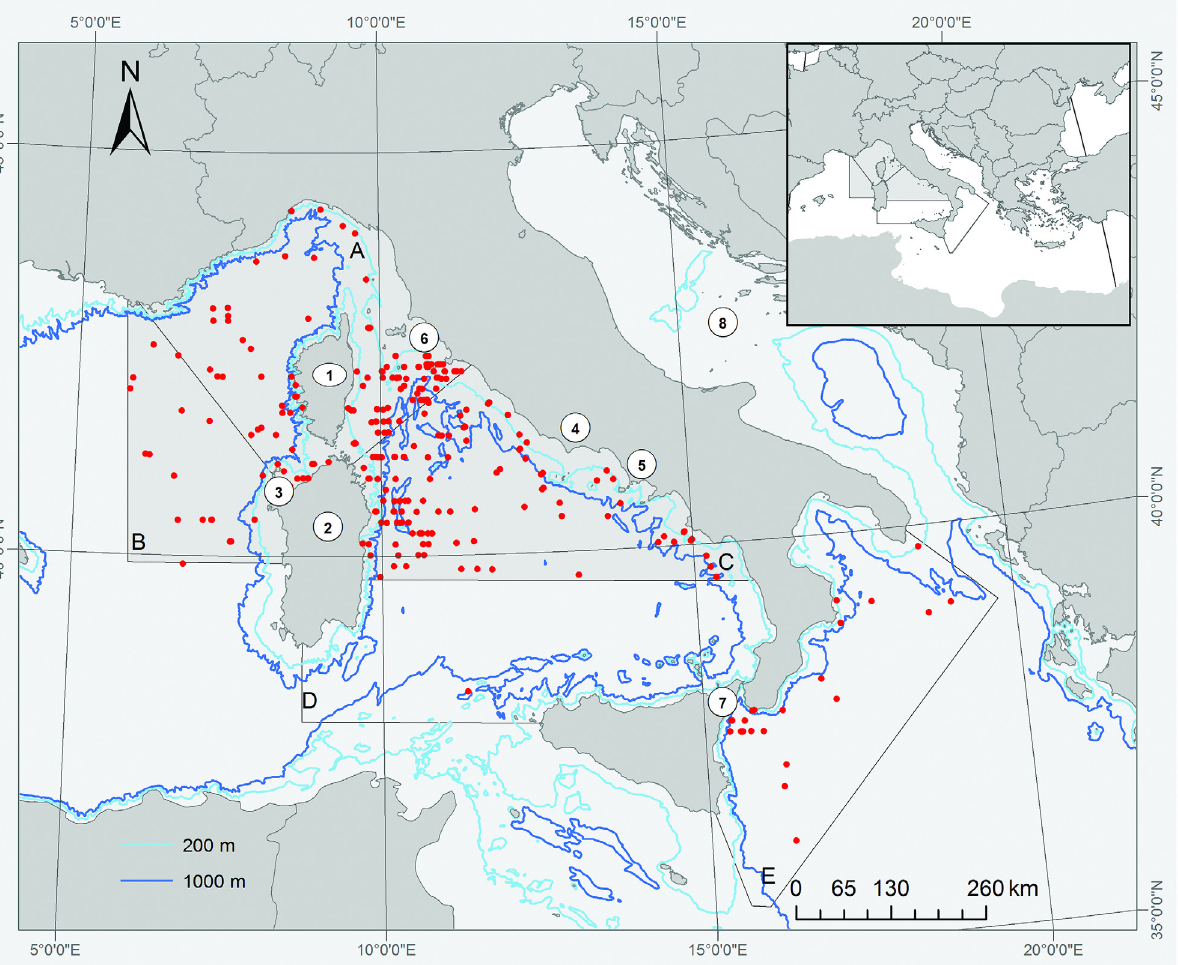
Fig 1. The study area subdivided into 5 sub-areas: (A) Pelagos Sanctuary; (B) Sardinian Sea; (C) Central Tyrrhenian Sea; (D) Southern Tyrrhenian Sea; and (E) Ionian Sea. Red dots are the locations of giant devilray sightings. The areas for which abundance estimates were obtained (A, B and C) are highlighted in grey. Numbers correspond to the following locations cited in the text: 1 – Corsica; 2 – Sardinia; 3 – Gulf of Asinara; 4 – Latium; 5 – Campania; 6 – Tuscan Archipelago; 7 – Strait of Messina; 8 – Adriatic Sea.